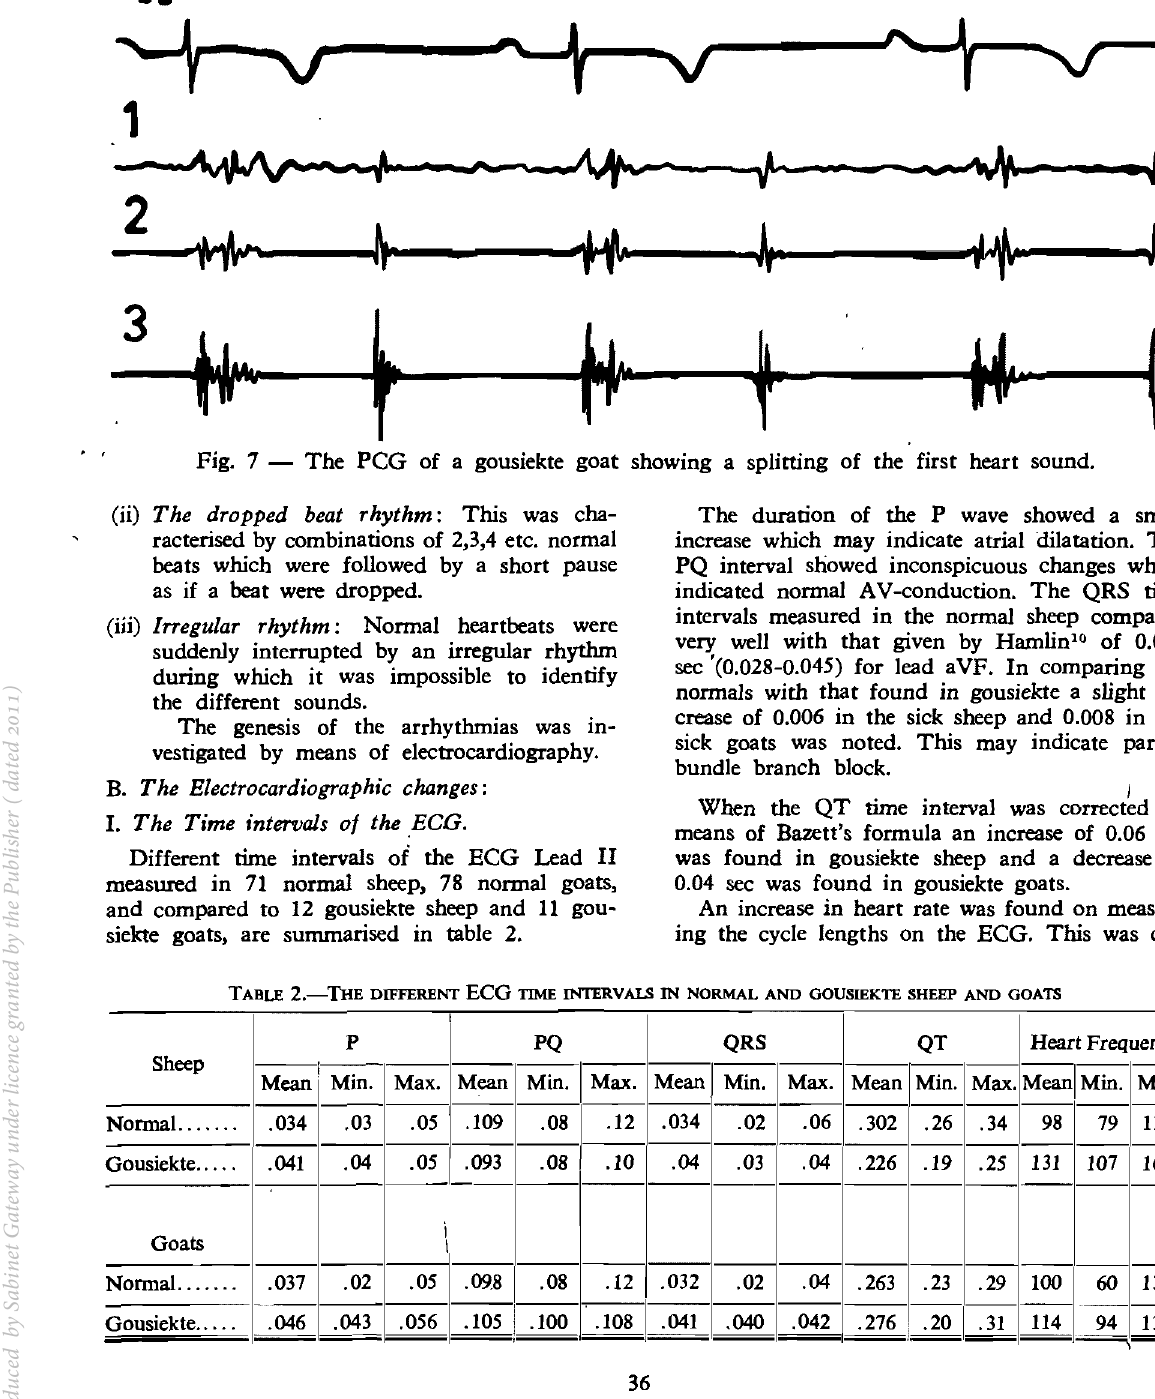
TABLE 2.-THE DIFFERENT EeG TIME INTERVAI.3 IN NORMAL AND GOUSIEKTE SHEEP AND GOATS P PQ QRS QT Heart Frequency